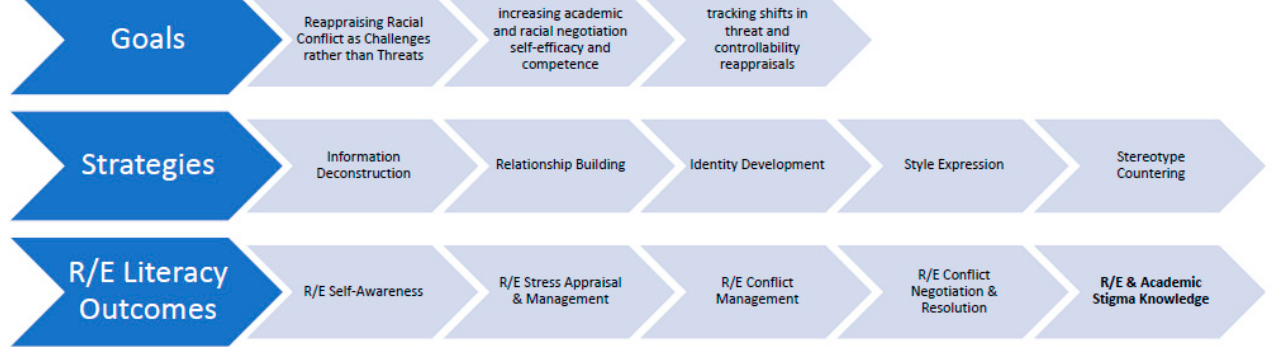
Figure 1. Let’s Talk goals, strategies, and outcomes.